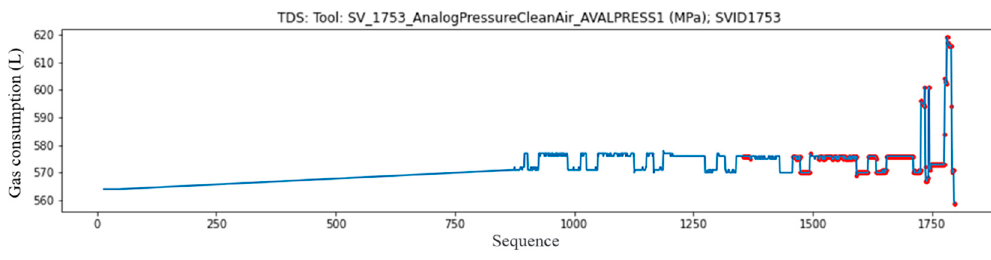
Figure 14. ( a ) mode CH1 in the wafer ID TR7VC470W12C2; ( b ) mode CH2 in the wafer ID TR7VC470W12C2; ( c ) mode CH1 in the wafer ID TR7W1101W04F7; ( d ) mode CH2 in the wafer ID